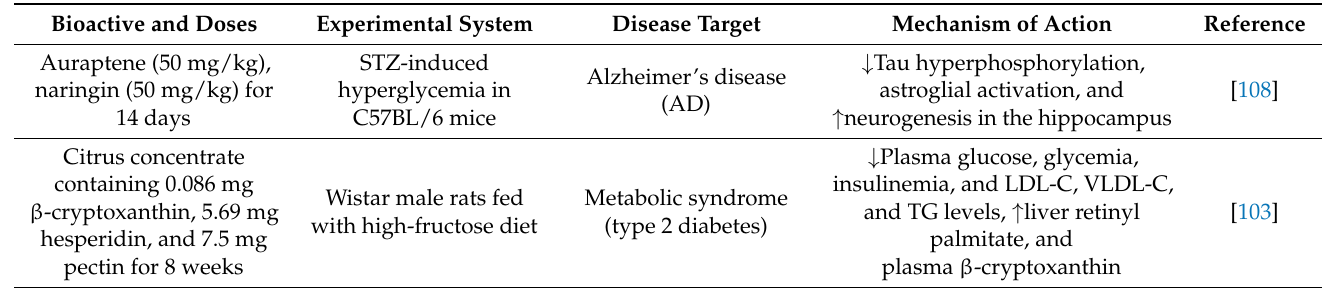
Table 4. Health benefits of citrus fruit bioactive compounds demonstrated using the animal